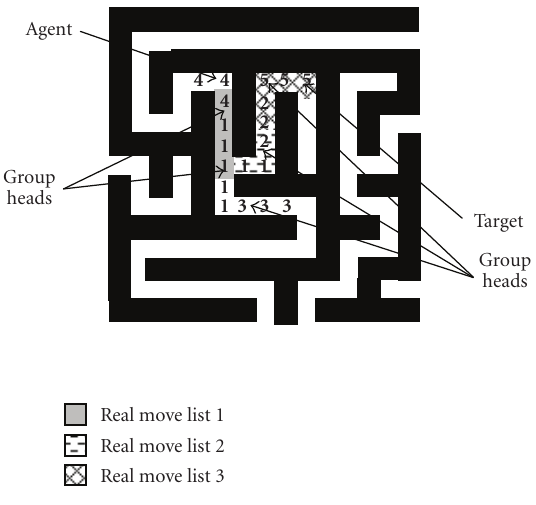
Figure 2: Abstraction maze